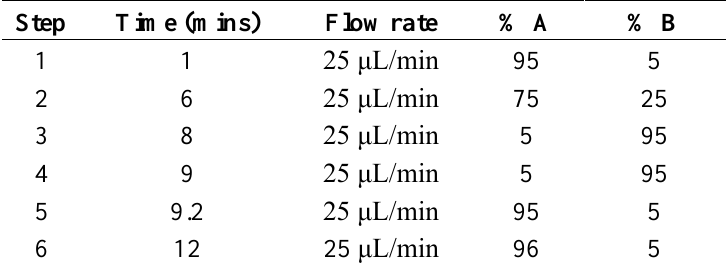
Table 1. Gradient elution used for analysis of